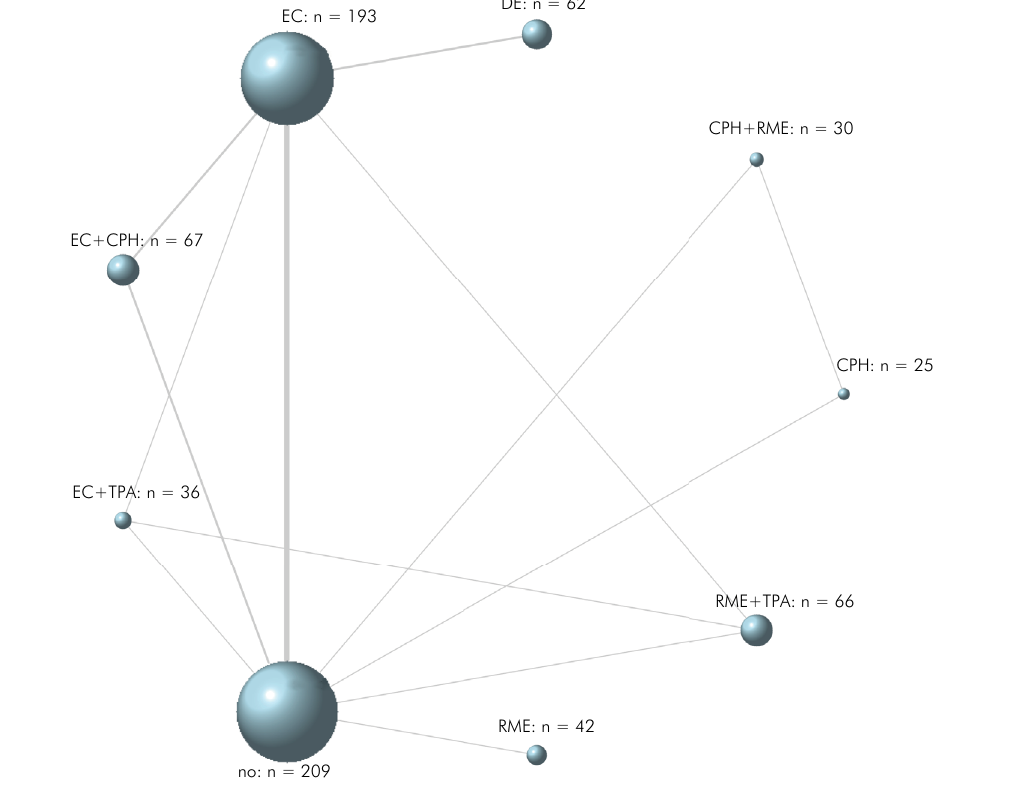
Figure 2. Network plot of treatment comparisons for Bayesian network meta-analysis. The size of the nodes (blue circles) corresponds to the sample size of the interventions. Comparisons are linked with a line, of which the thickness corresponds to the number of trials that assessed the